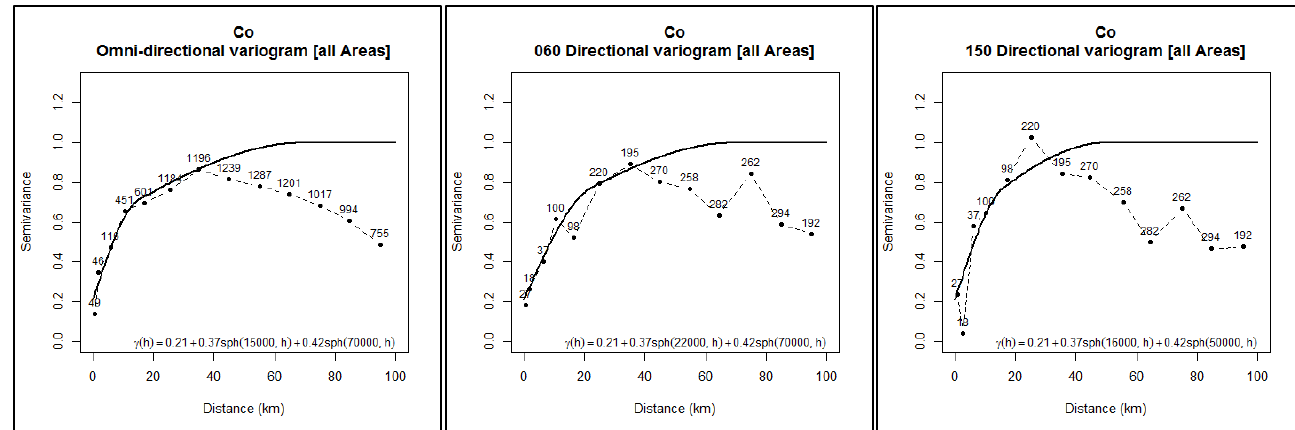
Figure 27. Co omni-directional, 060 ◦ and 150 ◦ directional variograms. Source: [12]. The variogram models for abundance generated from the box-core data were com- pared with variograms generated from the LAE abundance values. The variogram struc- tures were similar. The experimental variograms combining both physical samples and LAE in [12] showed ranges of around 5 km for abundance (Table 6, Figure 28) versus 5 to 22 km for grade (e.g., Figure 26). It is noted that variograms in [25] have a range of around 3 km for abundance from the NORI D Area. Table 6. Model abundance variogram models.